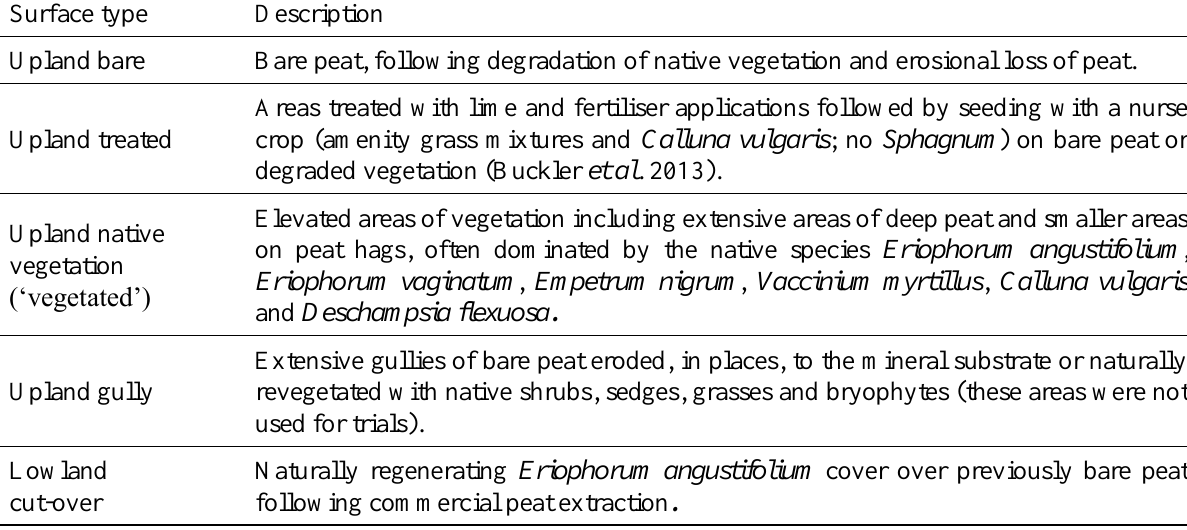
Table 1. The main classes of surface on upland blanket bog and lowland cut-over peatland, as defined for this